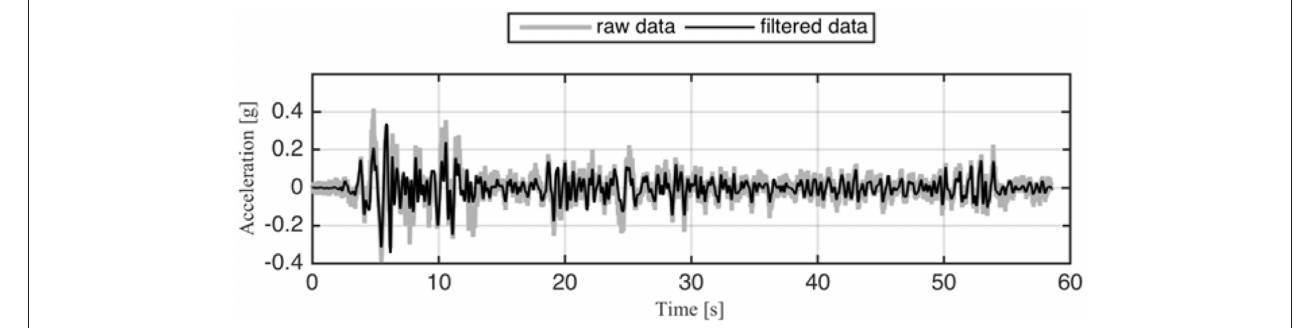
FIGURE 3 | 1940 El Centro earthquake record.